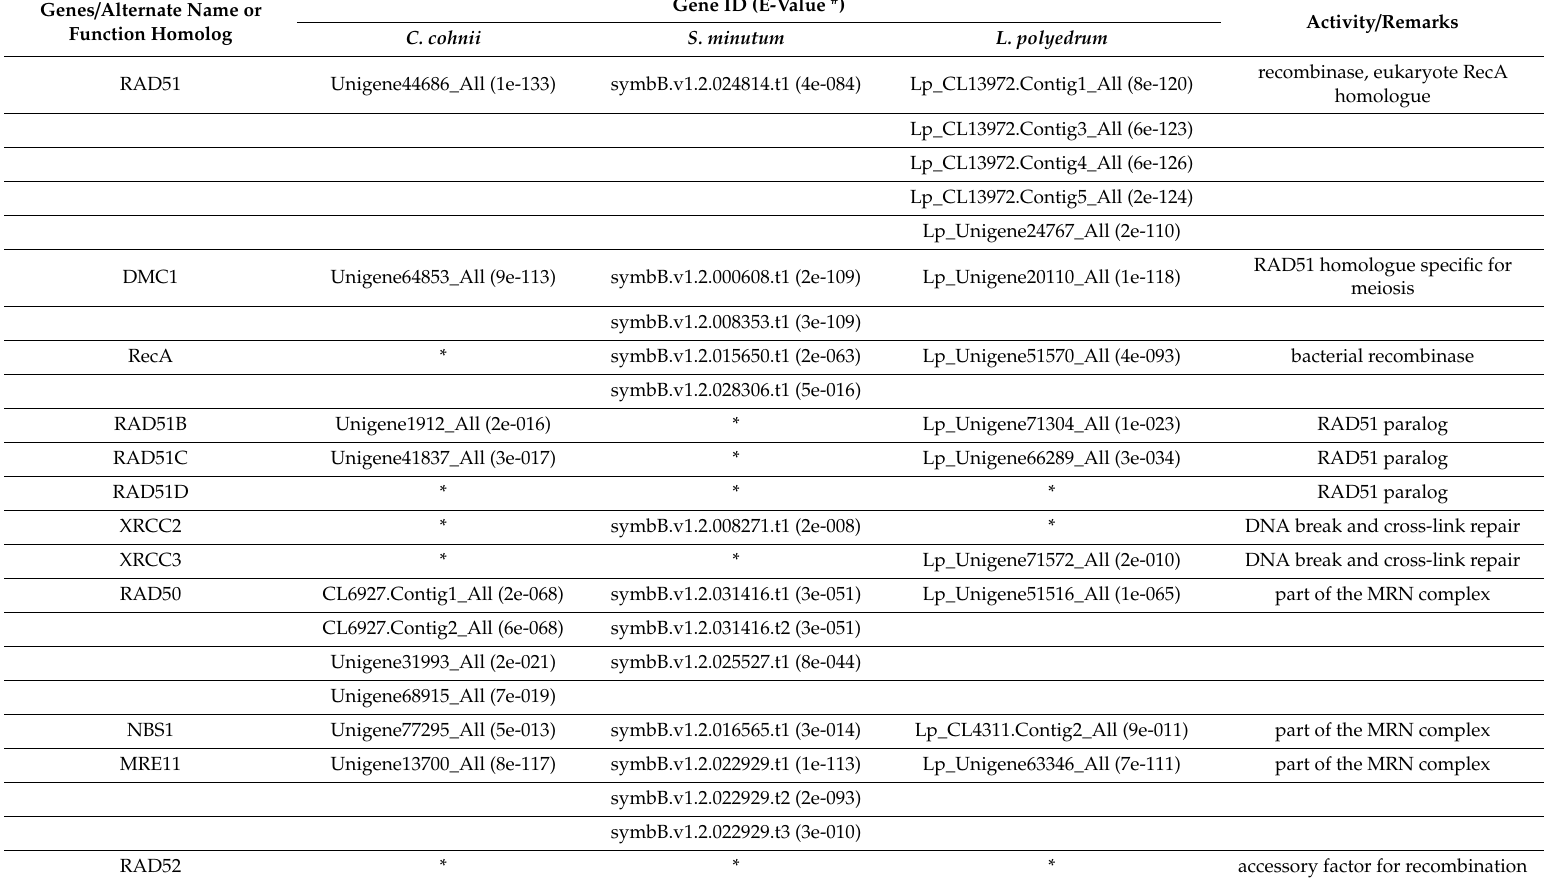
Table 7. Predicted dinoflagellate orthologues in homologous